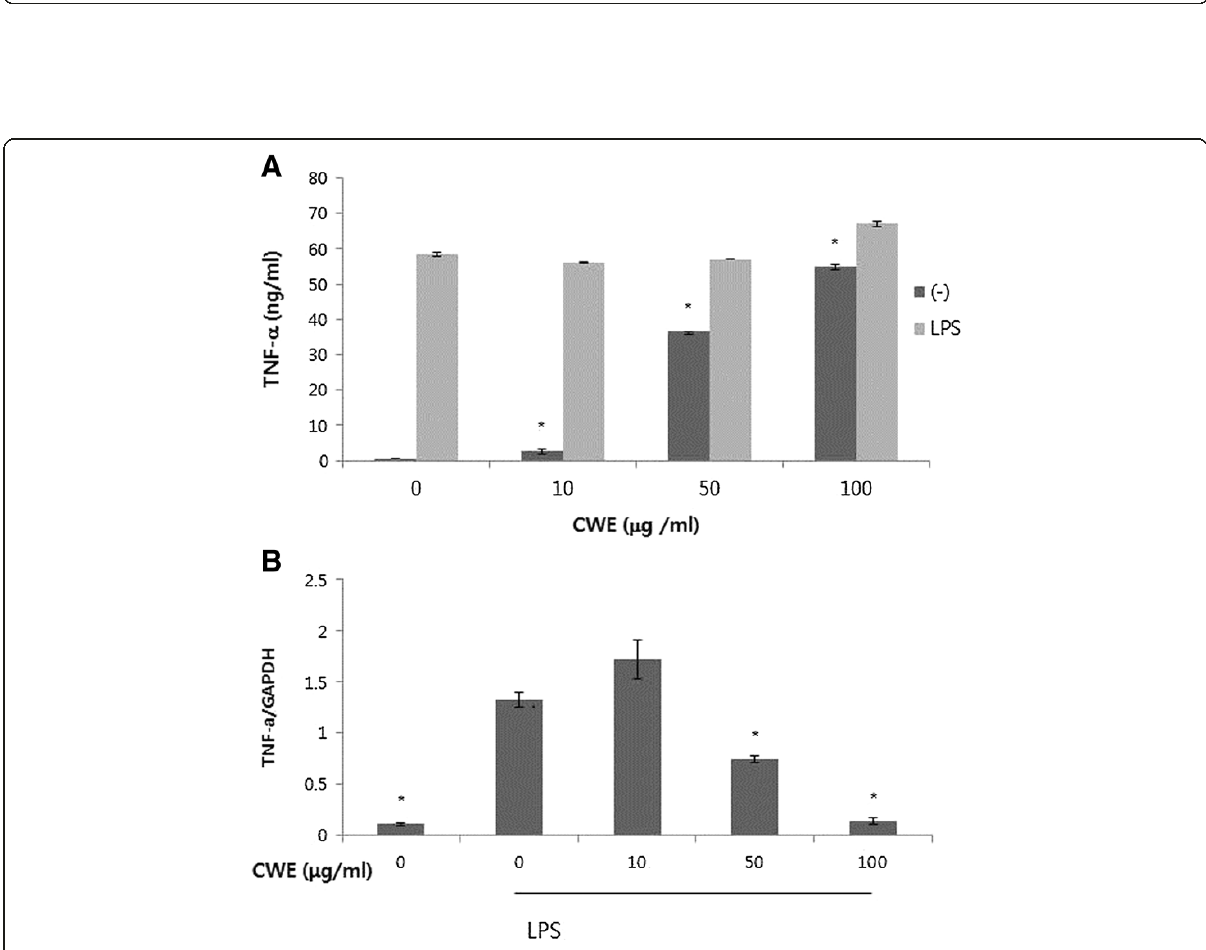
Figure 3 In vitro effect of CWE on LPS - induced TNF - α expression in macrophages. A : Peritoneal macrophages were treated with CWE for 24 h in the absence or presence of LPS. CWE was added 1 h before LPS stimulation. Supernatants were collected and cytokine levels were measured by ELISA. * P <0.05 compared with non-treated cells. B : Peritoneal macrophages were pretreated with CWE for 1 h and then stimulated with LPS for 4 h. Total RNA was prepared and realtime RT-PCR was performed. Glyceraldehyde 3-phosphate dehydrogenase (GAPDH) was used as an internal control. * P <0.05 compared with cells treated with LPS only. Data are expressed as the mean ± SD of four independent